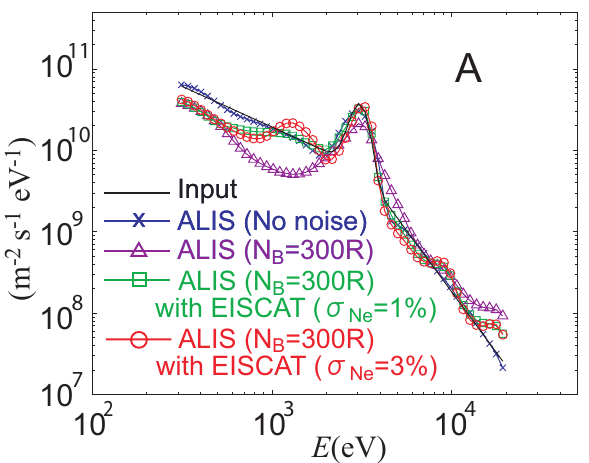
Fig. 7. The differential flux of the incident electrons at point A re- constructed from only auroral images (purple curve) and from both the auroral images and the EISCAT electron density (green and red curves). A background noise of 300R was added to the image data and a Gaussian noise with a mean of 0m − 3 and a 1% (3%) stan- dard deviation. Black and blue curves correspond to the differential flux of the original incident electrons and the differential flux recon- structed from auroral images with no noise, respectively.